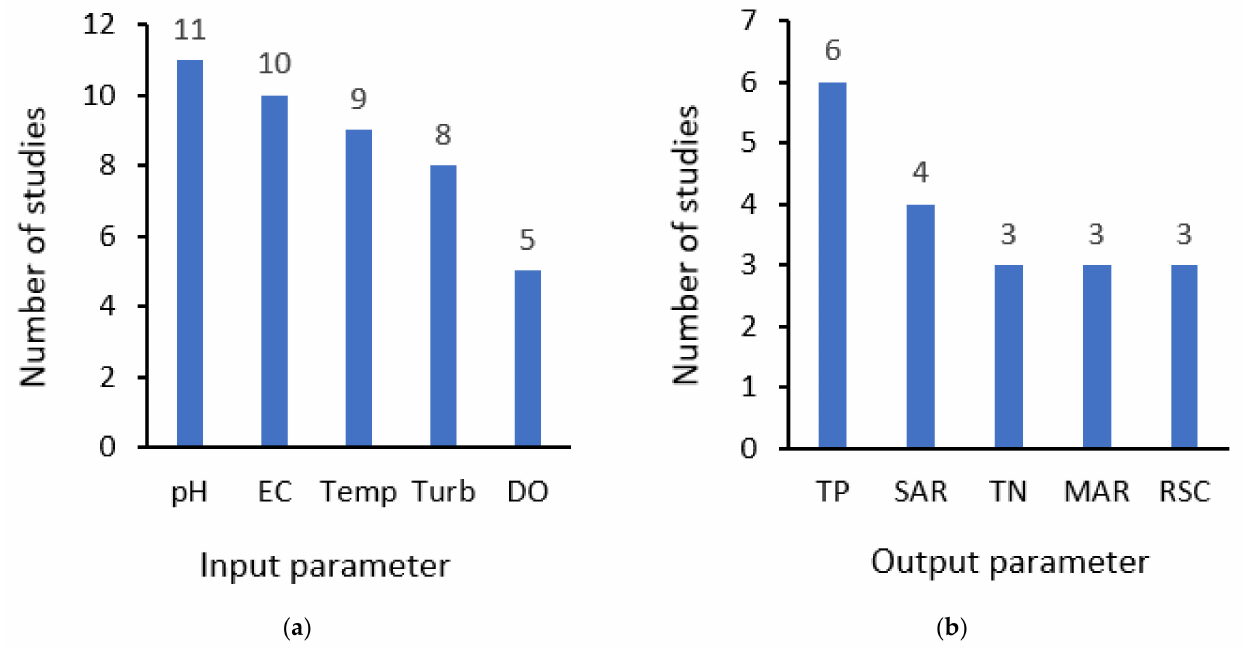
Figure 5. ( a ) Commonly used input parameters; ( b ) Commonly predicted